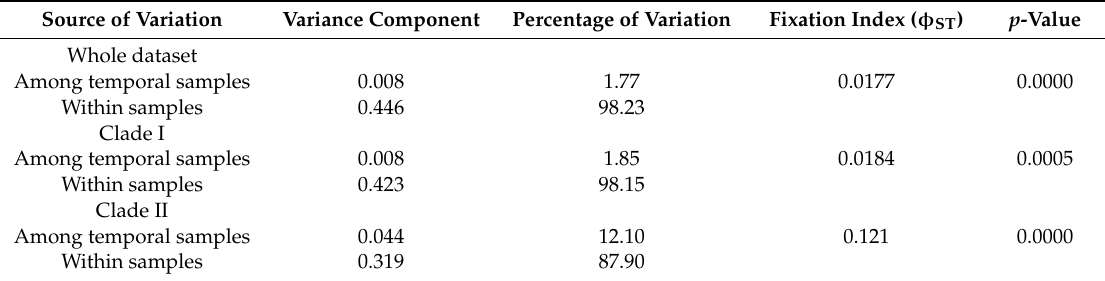
Table 4. AMOVA results of Mediterranean swordfish temporal sample comparison.